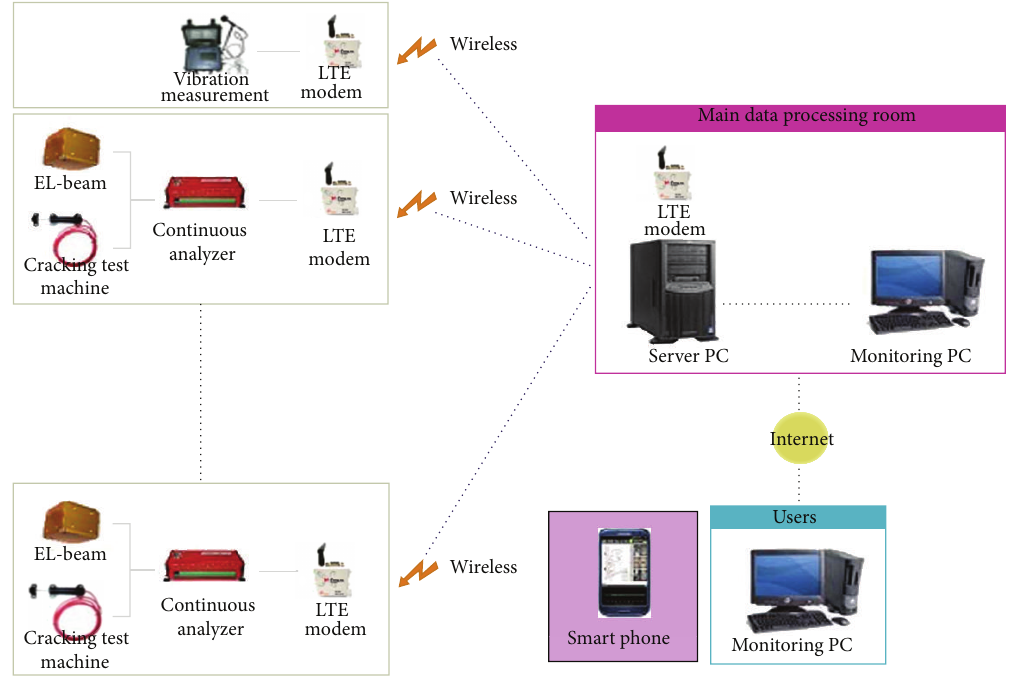
Figure 9: The system structure.